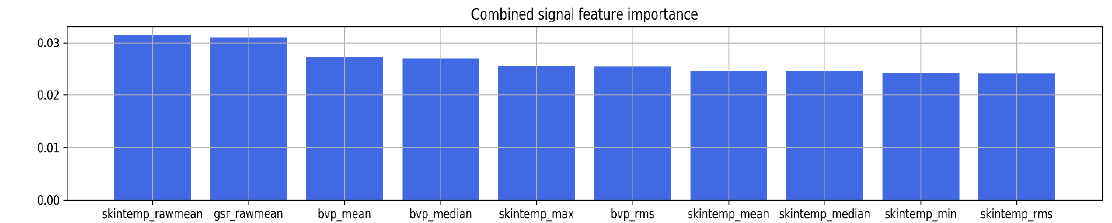
Figure 9. Feature importance signal fusion (top 10 features are shown).